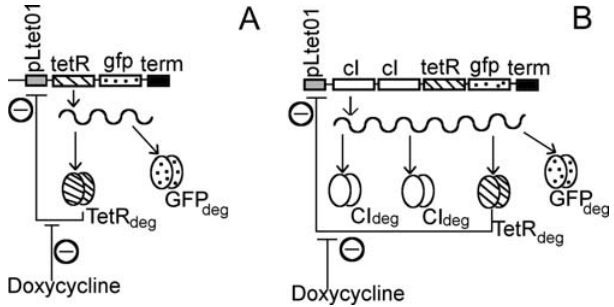
Figure 1. Design of negatively auto-regulated gene circuits: (A) Basic (TG), and (B) Delay (C2TG). See text for details.